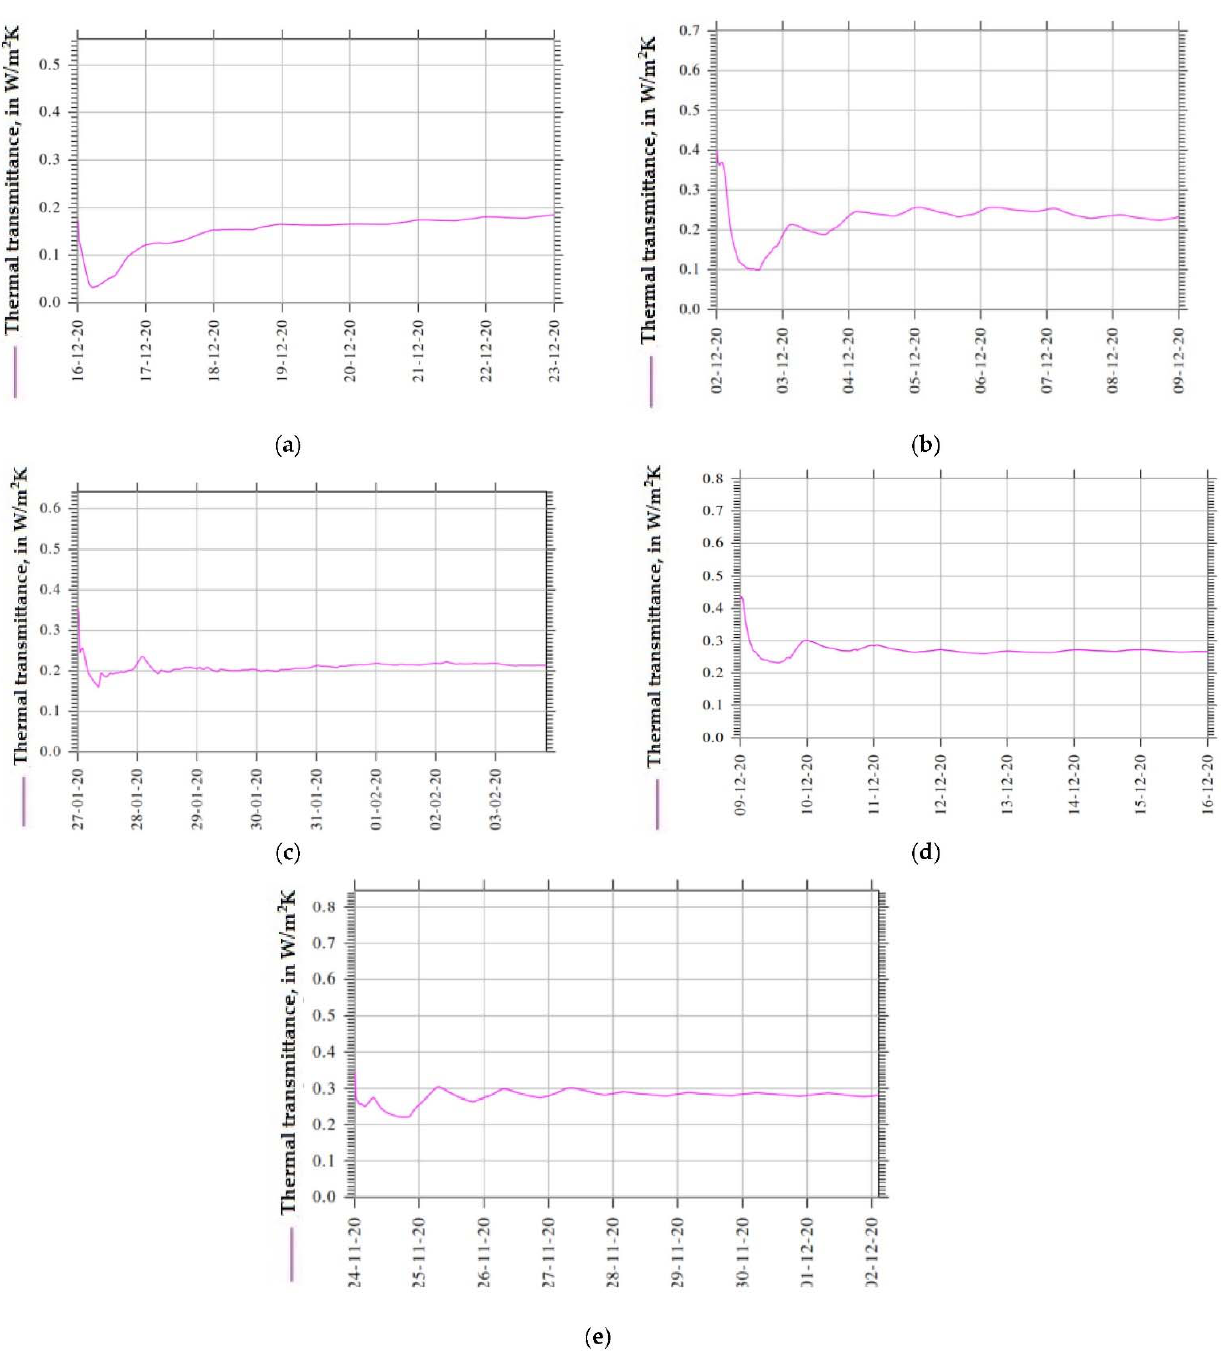
Figure 4. In situ measurements diagrams of thermal transmittance of the structures with the following fillers: ( a ) wood fibers; ( b ) ground paper; ( c ) wool; ( d ) ABS waste; ( e ) reed. In order to compare the calculated U values (U c ) with measured in situ values (U i ), the thermal resistance ( R ) recorded for ∆ T = 10 ◦ C was used for U c calculation. This thermal resistance was selected due to the close values of the temperature differences with those from the measurements taken in real conditions (in situ). The comparison between U c and U i for all experimental wall structures is shown in Figure 7. As seen from the diagram, the calculated U values are higher than those measured in real conditions for seven days. These differences ranged between 7.64% (structure with ABS waste filler) and 56.3% (structure with wood fibers filler). This result contradicts the conclusions of